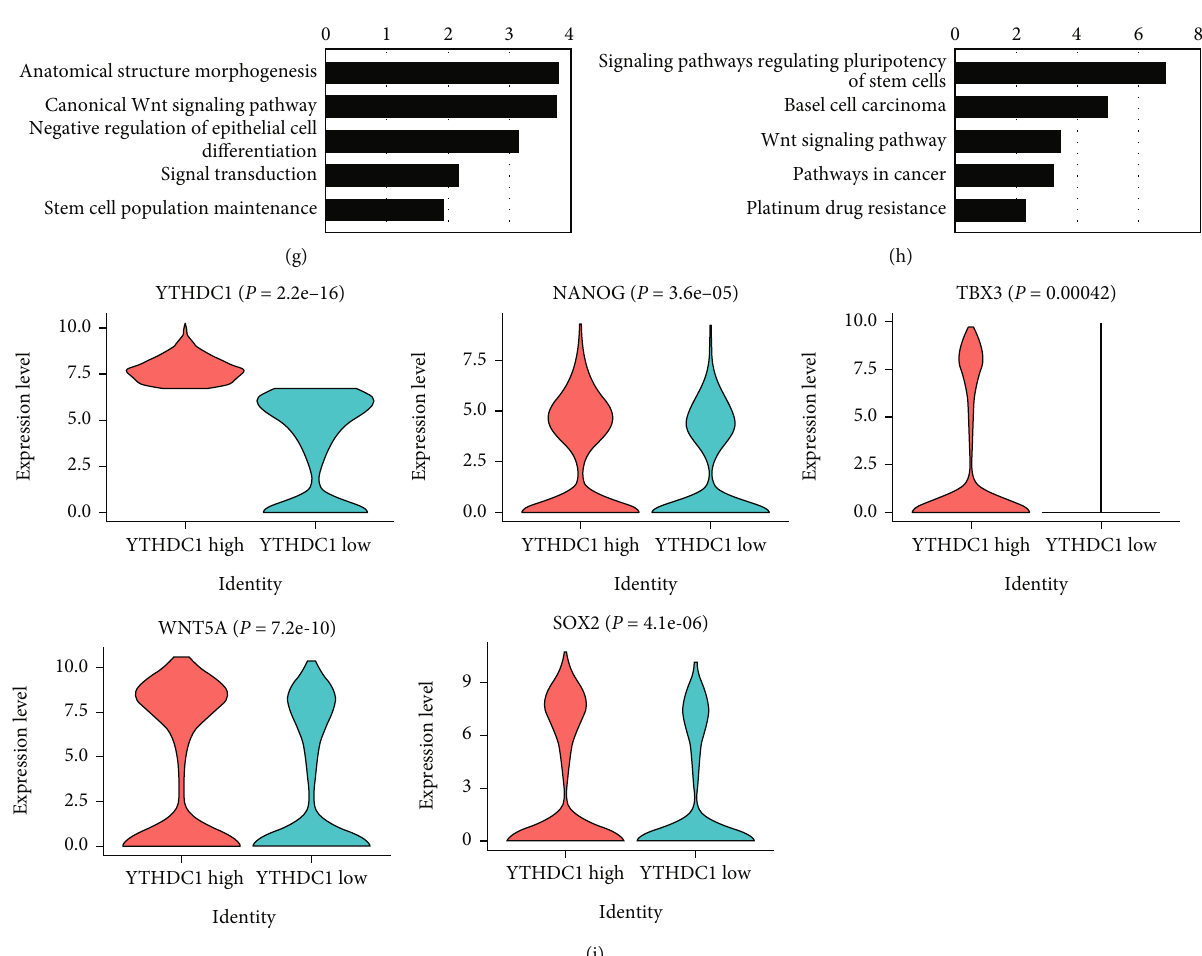
Figure 5: Validation of the role of YTHDC1 in regulating stemness maintenance at the single cell level. (a) The UMAP plot of scRNA-seq cell data labeled by cell type. (b) The UMAP plot of the YTHDC1 expression in all the clusters. (c) The UMAP plot of cancer cells from HNSCC tissues shows the YTHDC1 expression pattern. (d) The Pearson correlation between YTHDC1 and SOX2 mRNA expression according to the single cell RNA data. (e) The Pearson correlation between YTHDC1 and BMI1 mRNA expression according to the single cell RNA data. (f) Volcano plot shows di ff erentially expressed genes between YTHDC1 high and YTHDC1 low cells. (g) GO analysis of the upregulated genes in the YTHDC1 high expression cell population. (h) KEGG analysis of the upregulated genes in the YTHDC1 high expression cell population. (i) Violin plot depicts the expression of stem cell-related markers of YTHDC1 high and YTHDC1 low